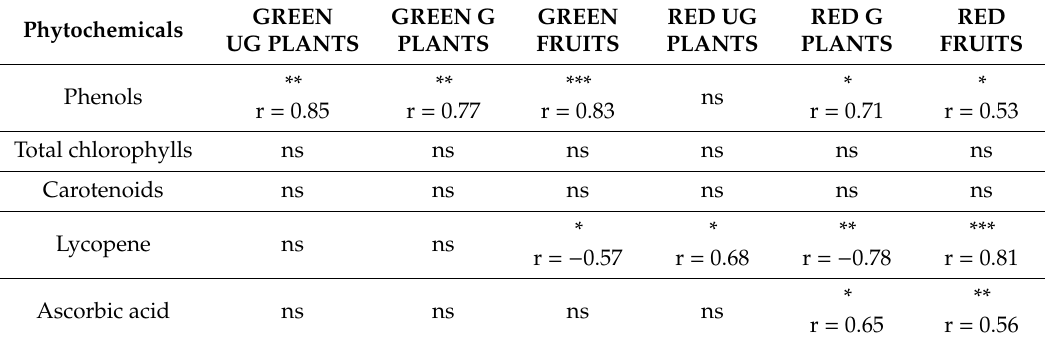
Table 2. Correlation coe ffi cients and their significance determined between each phytochemical and antioxidant capacity produced by the green and red fruit produced by the grafted (G) or ungrafted (UG) landraces on rootstock F1 NIBER ® . Correlation coe ffi cient r is reported when the correlation was